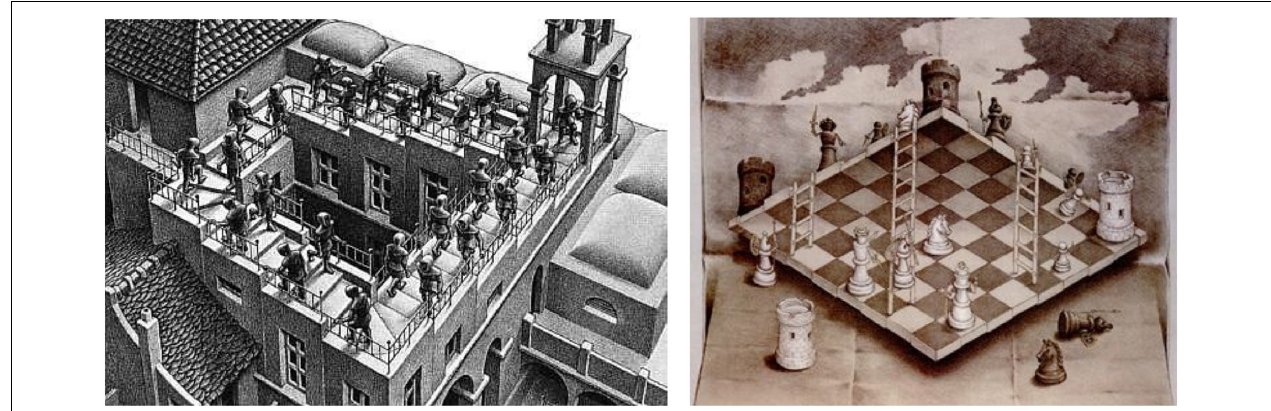
FIGURE 6 | Two examples of ambiguity in the 3D interpretation of complex images: Ascending Staircase by Mauritz Escher, and Two-Sided Chessboard by Sandro del